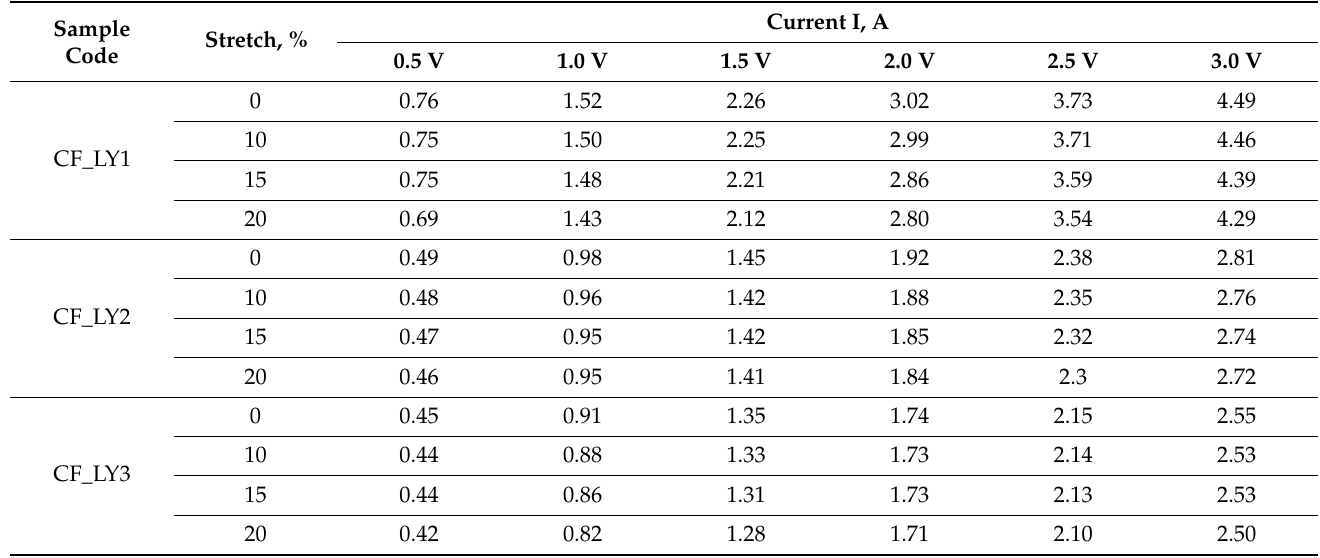
Table 2. Influence of stretching on the current I generated in CF_LY1, CF_LY2 and CF_LY3 during employing different voltage V.